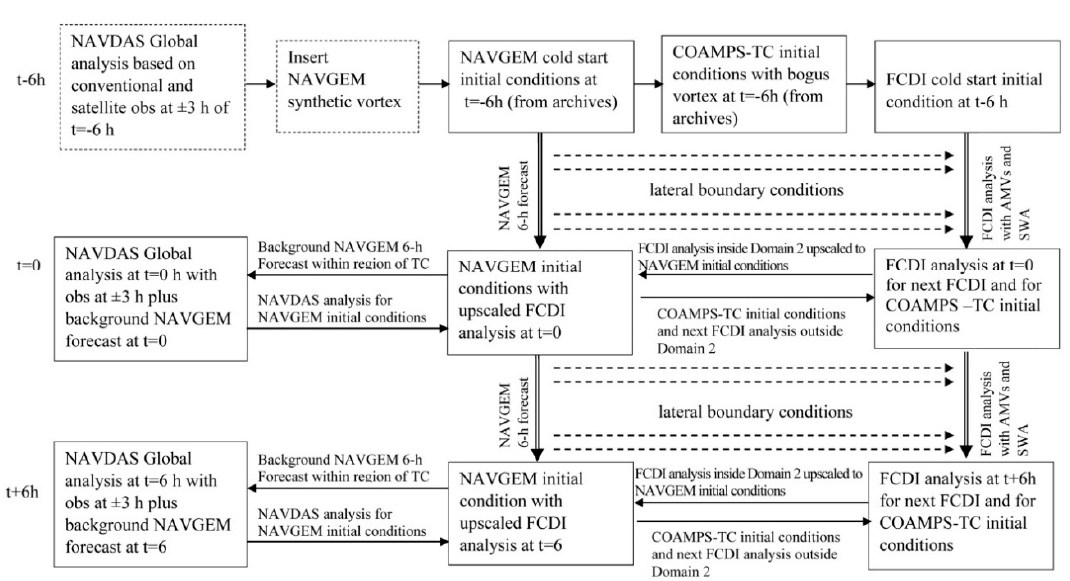
Figure 3. Flowchart of the full FCDI analysis procedure starting from six hours prior to the first detection of a pre-TC circulation so that the NAVGEM, the COAMPS-TC, and the FCDI are all cold starts. In this version that is similar to the Elsberry et al. (2018) [1] dynamic initialization, the FCDI analysis within Domain 2 at t = 0 h is upscaled to NAVGEM and is input to the NAVDAS-AR analysis, which is then downscaled to become the initial conditions outside of Domain 2 for the next FCDI analysis.